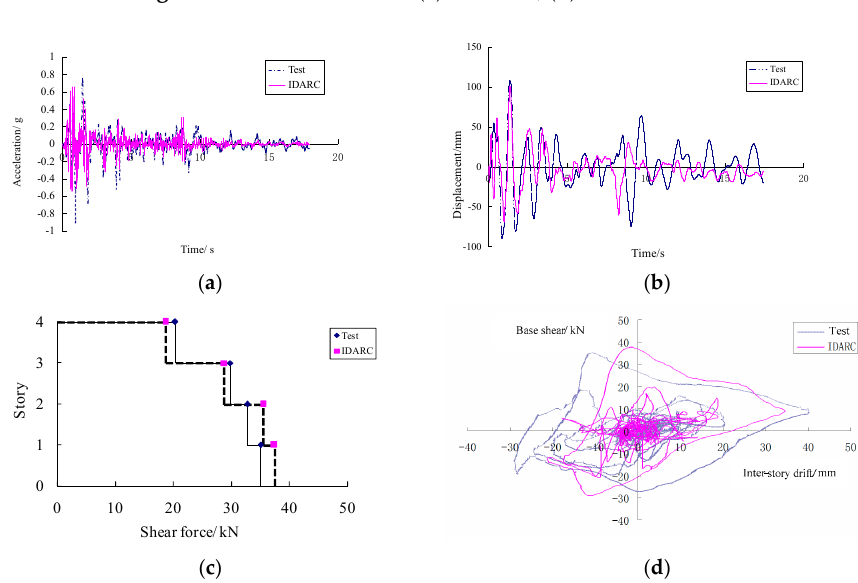
Figure 13. Comparison of the test and numerical responses under Run 5 ( PGA = 0.66 g). ( a ) Acceleration response at the top story; ( b ) Displacement response at the top story; ( c ) Inter-story shear; ( d ) Hysteresis loop of the bottom story.